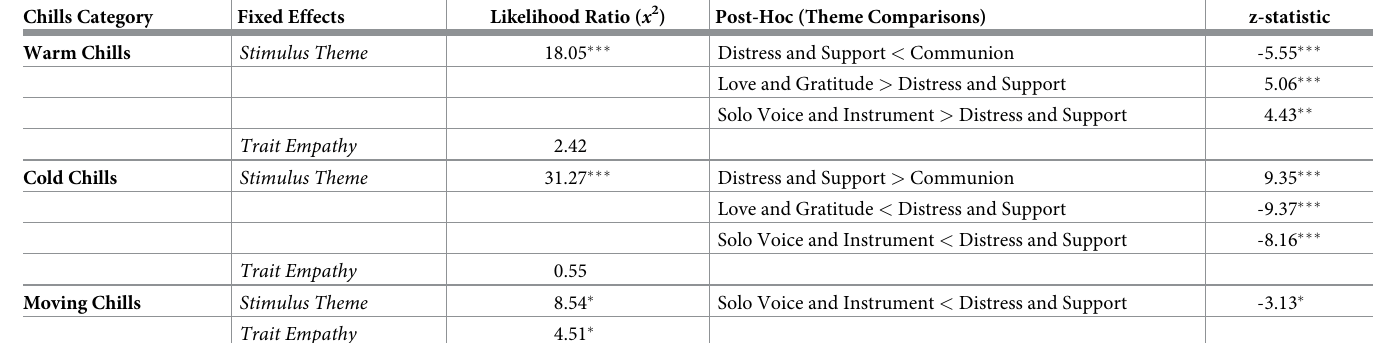
Table 4. Likelihood ratio tests statistics and post-hoc comparisons, to assess effects of stimulus themes and trait empathy on warm, cold and moving chills ( ��� = p < .001, �� = p < .01, � = p <